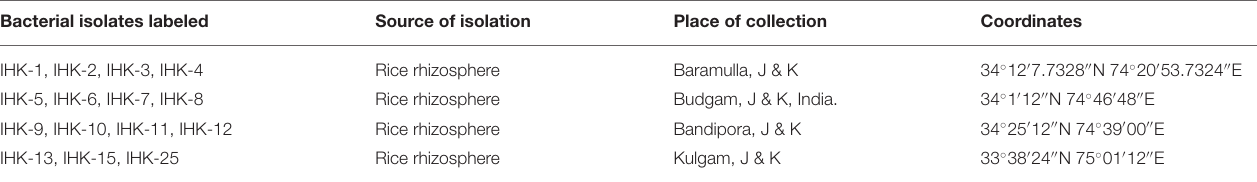
TABLE 1 | Collection details of